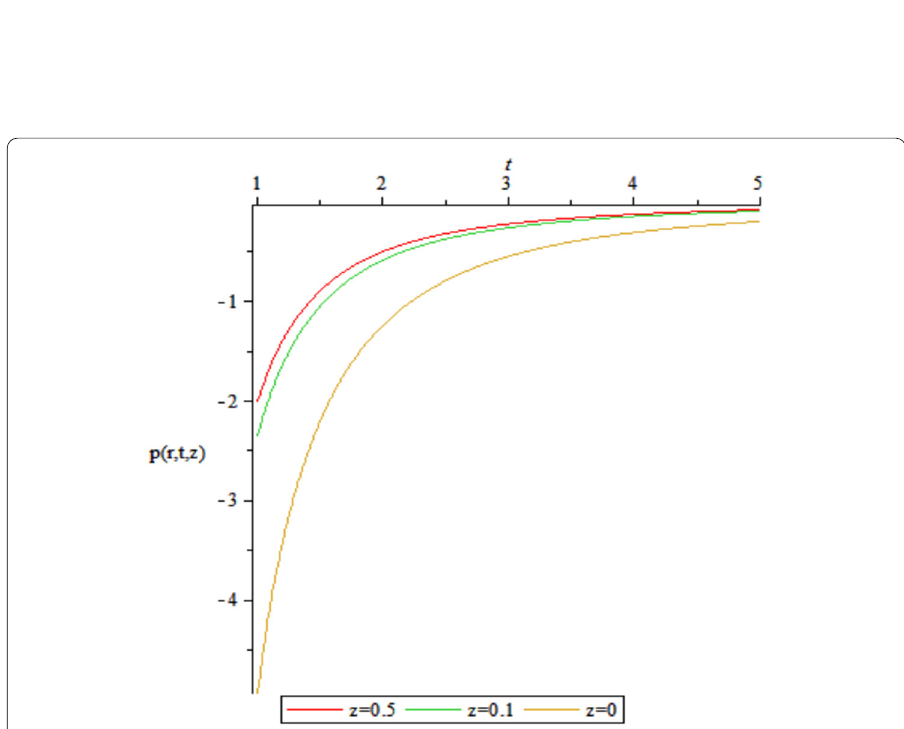
Figure 8 The pressure p ( r , t , z ) at c 1 = 1, c 3 = 1, and c 4 =